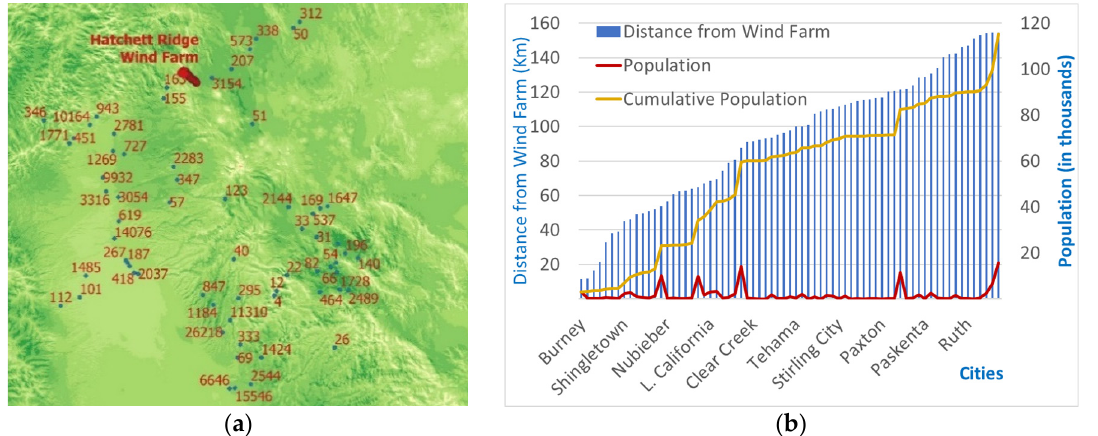
Figure 9. Cities (with population label) close to the Hatchet Ridge. ( a ) Location map; ( b ) GIS proximity and population analyses.